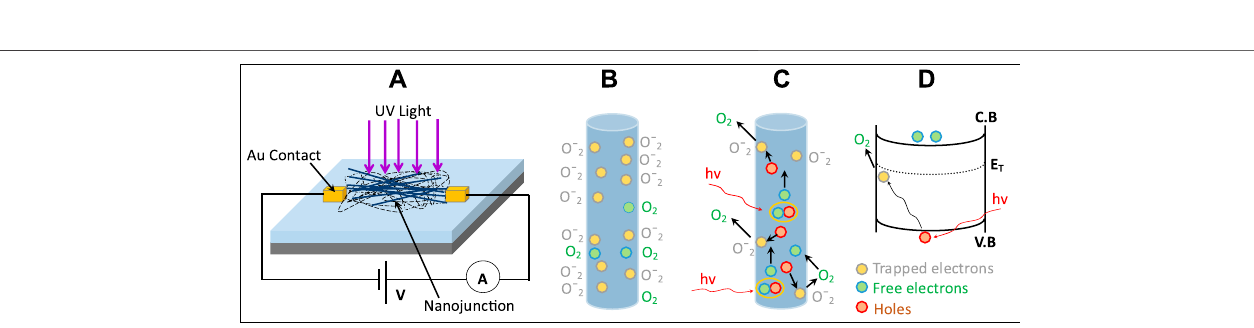
FIGURE 4 | Schematic of (A) UV sensor (B) photo response mechanism in dark (C) photo response in UV light. (D) Energy band diagram of the photo response process during UV-sensing.